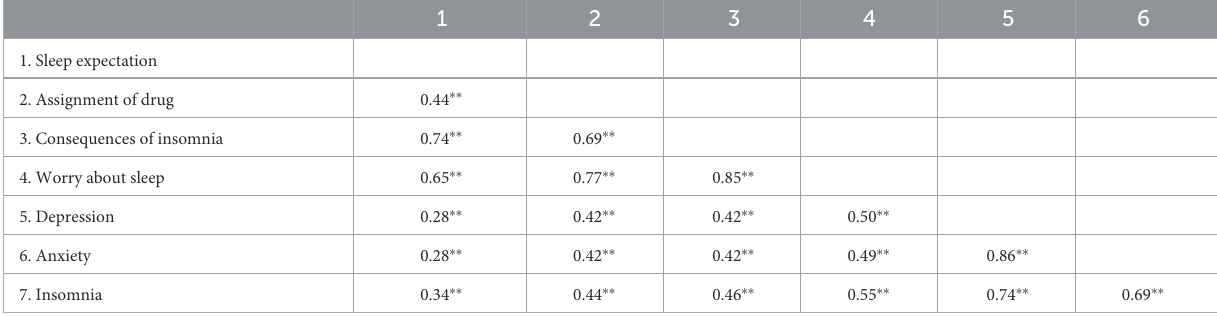
TABLE 2 Pearson correlation analysis among all